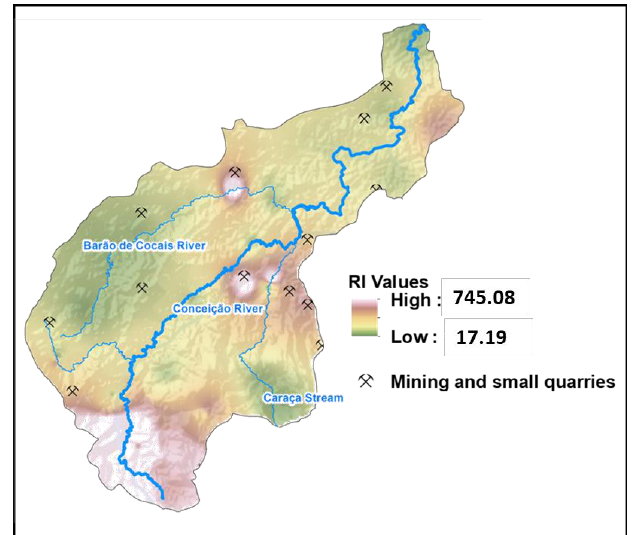
Figure 9. RI values distribution map.